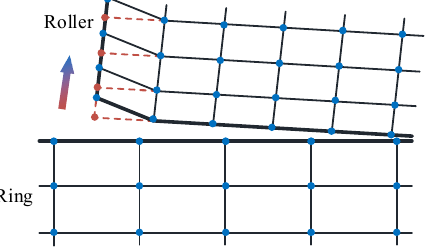
Figure 15. Radial shrinkage of mesh at roller edge.